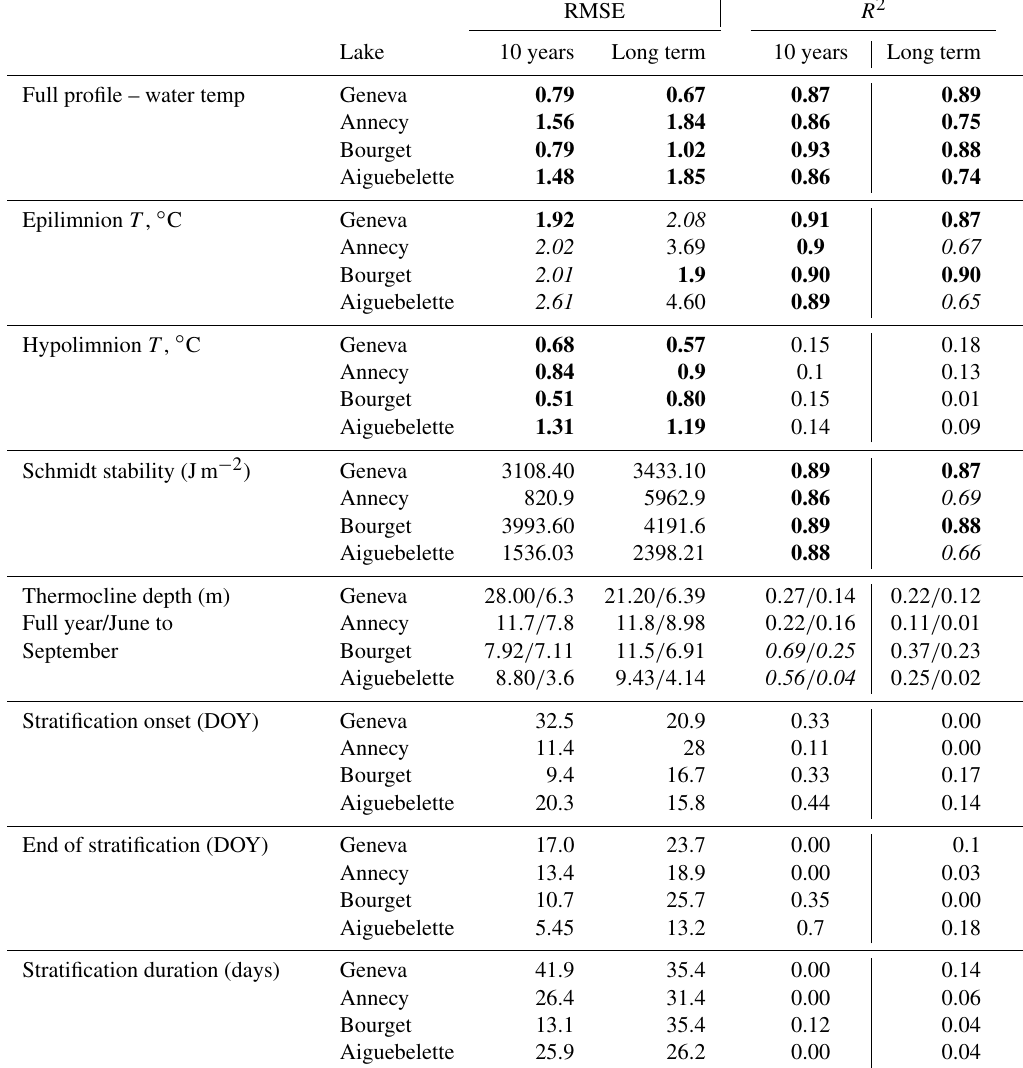
Table 7. Comparison of model validation metrics for eight thermal indices over 10 years and a long-term validation period (37 to 63 years) for the four lakes (see extended Table S6); bold: RMSE < 2 ◦ C and R 2 > 0 . 7; italics: RMSE < 2 . 7 ◦ C and R 2 > 0 . 5. RMSE R